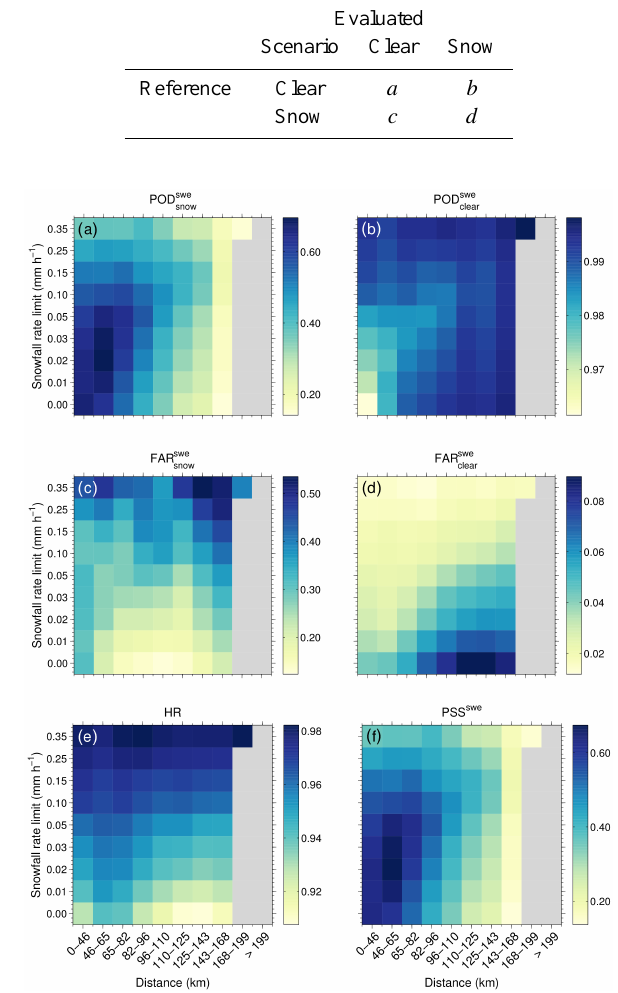
Table 2. Contingency matrix for observations from CloudSat and Swerad.